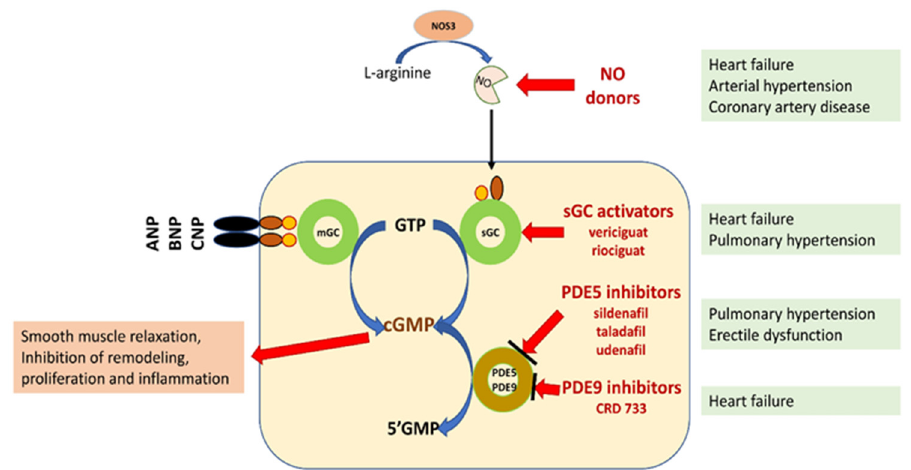
Figure 1. Schematic representation of the potential for pharmacological interference with the NO/sGC/cGMP pathway [3,5–7]. Explanation of abbreviations: sGC—soluble form of guanylyl cyclase; mGC—membrane form of guanylyl cyclase; NO—nitric oxide; eNOS—nitric oxide synthase; ANP, BNP, CMP—natriuretic peptide A, B or C; GMP 3 ′ -5 ′ —guanosine monophosphate; GTP 3 ′ -5 ′ —guanosine triphosphate; cGMP cyclic 3 ′ -5 ′ —guanosine monophosphate; CNGCs—cyclic nucleotide gated channels; PKG—protein kinase G; PDE phosphodiesterase.